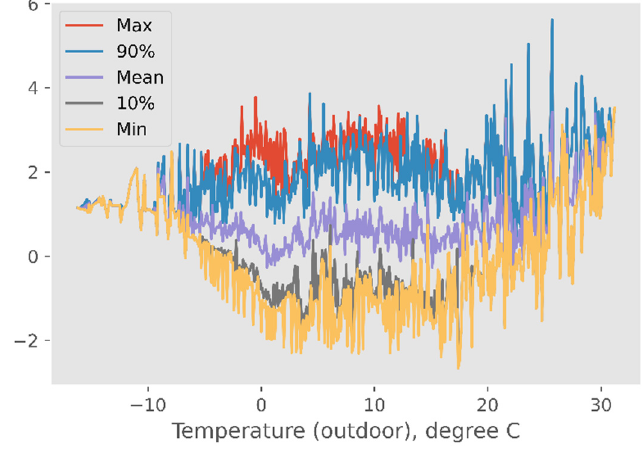
Figure 13. Average moisture excess in Turaida church on the lamp.